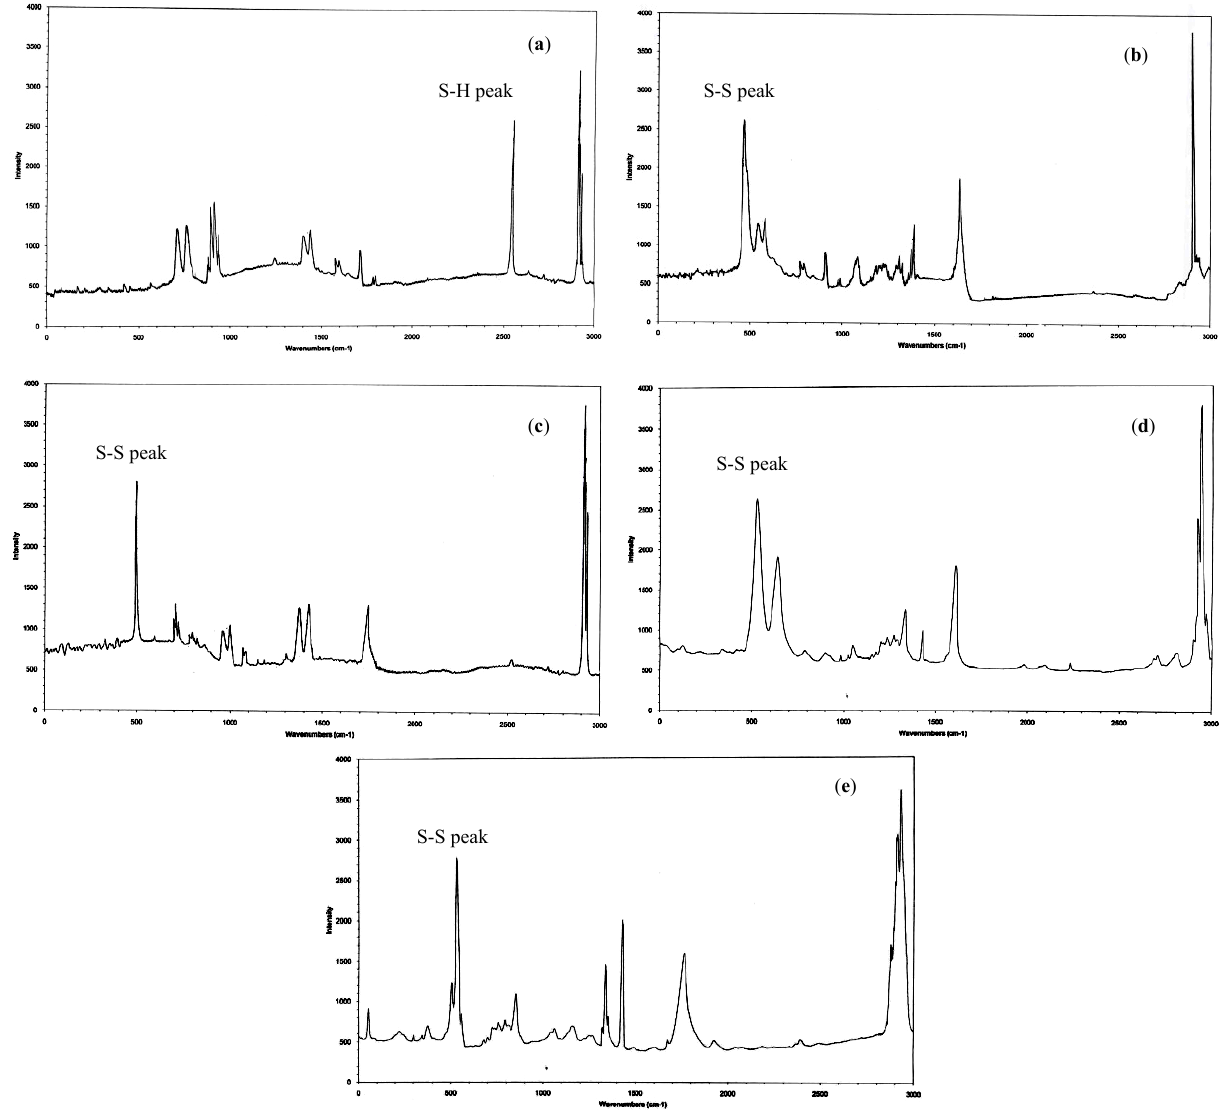
Figure 1. Raman spectra of ( a ) the trithiol monomer and polymers ( b ) P10; ( c ) P11; ( d ) P151; and ( e )